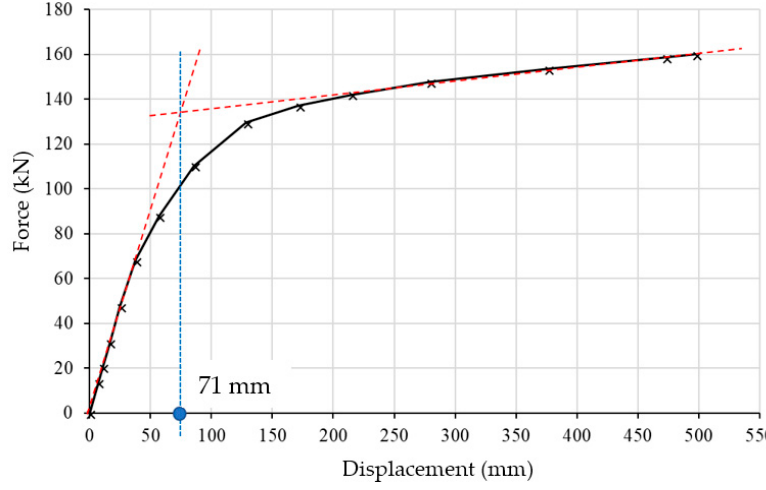
Figure 20. Structural displacement at first yield approximation.